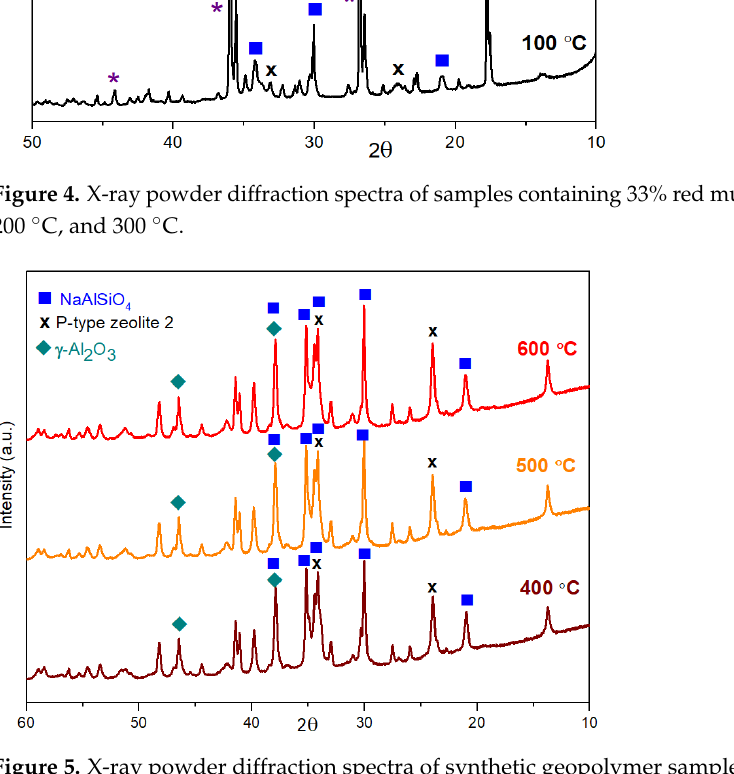
Figure 5. X-ray powder diffraction spectra of synthetic geopolymer samples heat-treated at 400 °C, 500 °C, and 600 °C.